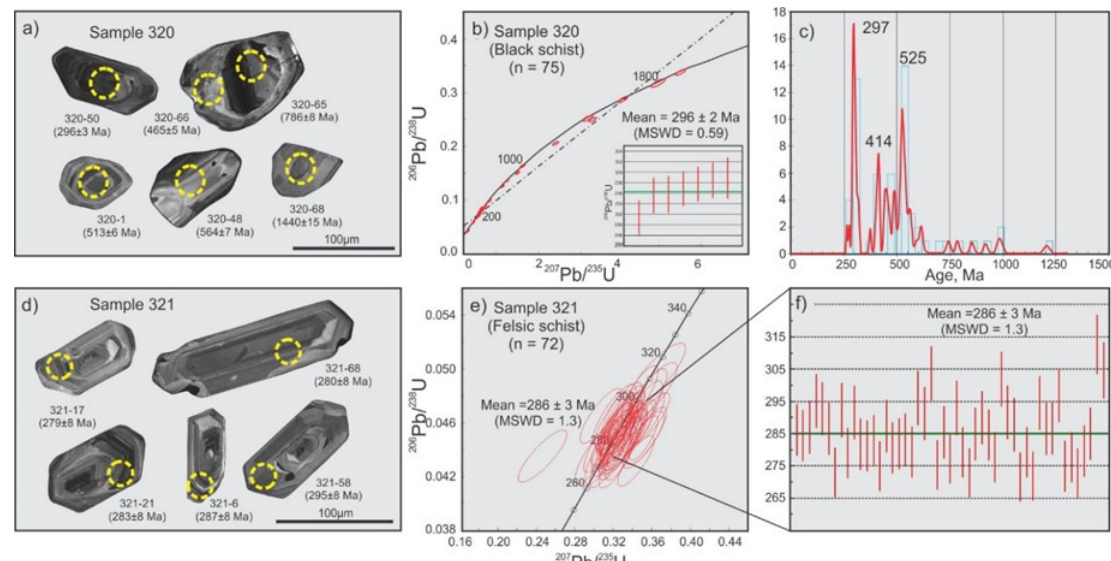
Fig. 6. CL images of typical zircons, zircon 207 Pb/ 235 U - 206 Pb/ 238 U concordia diagrams and age probability histograms of detrital zircons of Sample 320 (Black schist) and Sample 321 (Felsic schist) from Mogoitiin Gol area. The notation for each spot (a, d) consists of spot number and the 206 Pb/ 238 U age. Inserted small figures are weighted average ages of youngest zircon population of detrital